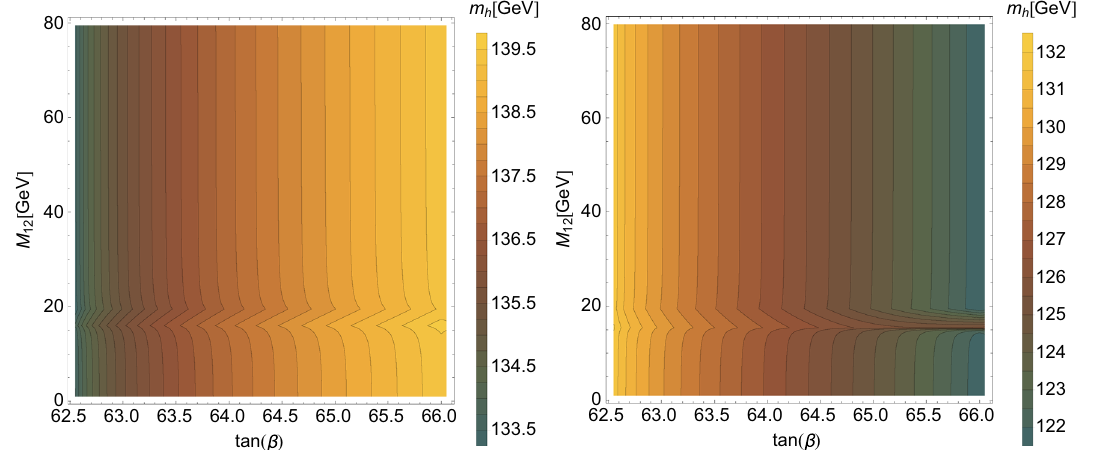
Fig. 7 Masses of M 12 -independent CP-even neutral scalar m h as a function of tan β and the soft breaking parameter M 12 . The vacuum-stable branch is shown on the left, the vacuum-unstable branch on the right